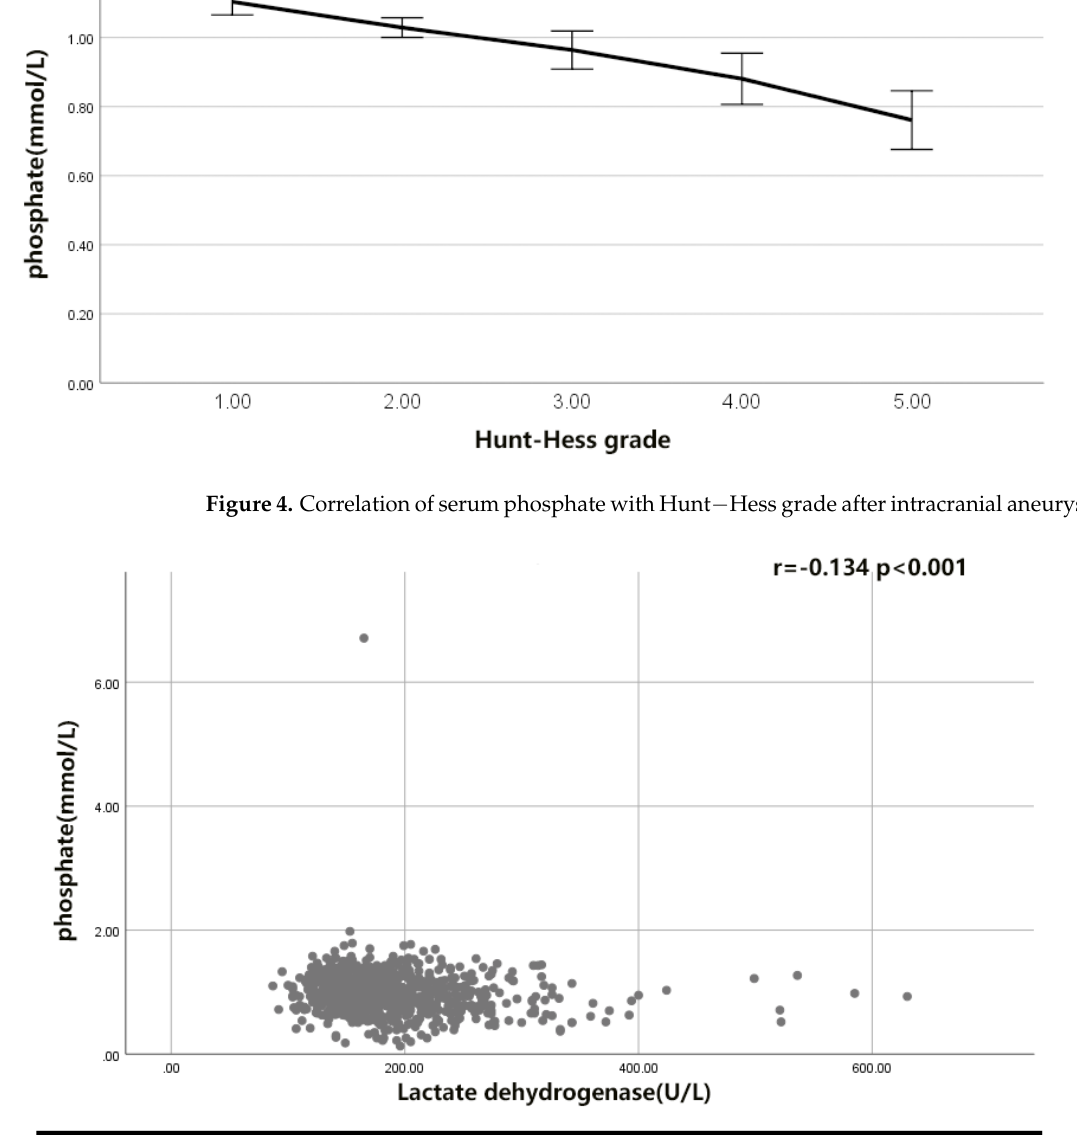
Figure 5. Correlation of LDH with phosphate after intracranial aneurysm rupture. Table 3. Multivariate analysis of risk factors associated with a poor outcome at 3